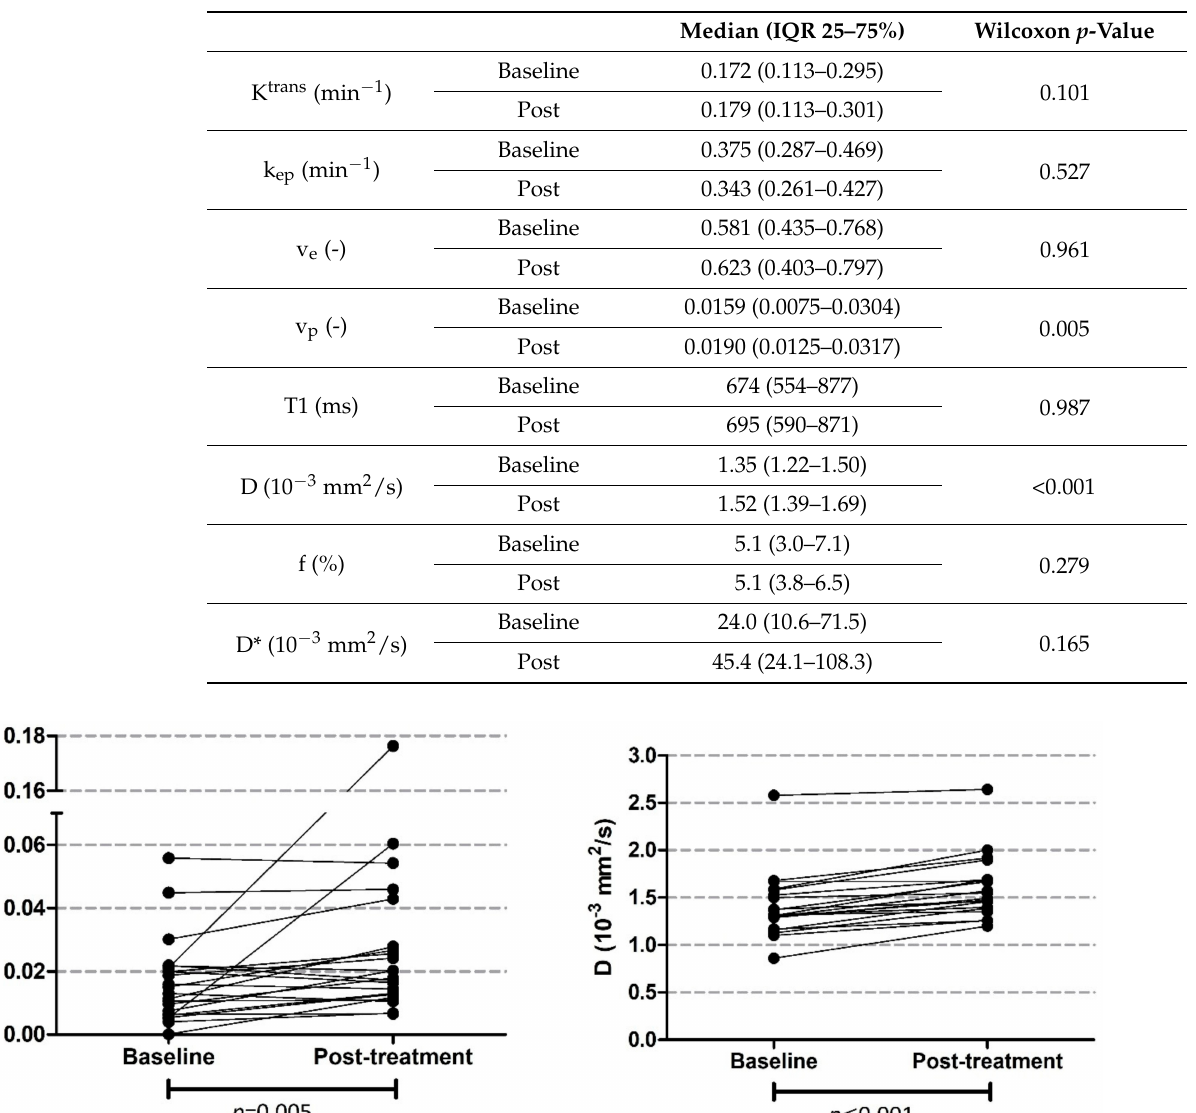
Table 5. Median and IQR values for DCE and IVIM parameters at baseline and post-chemotherapy. The p -value of the Wilcoxon signed-rank test is also presented. v p and D show a significant increase between baseline and post-treatment values.